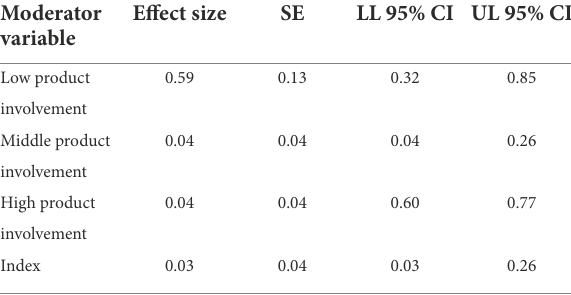
TABLE 10 Results for the effect of IEPEC on inconsistency purchase intention across levels of product